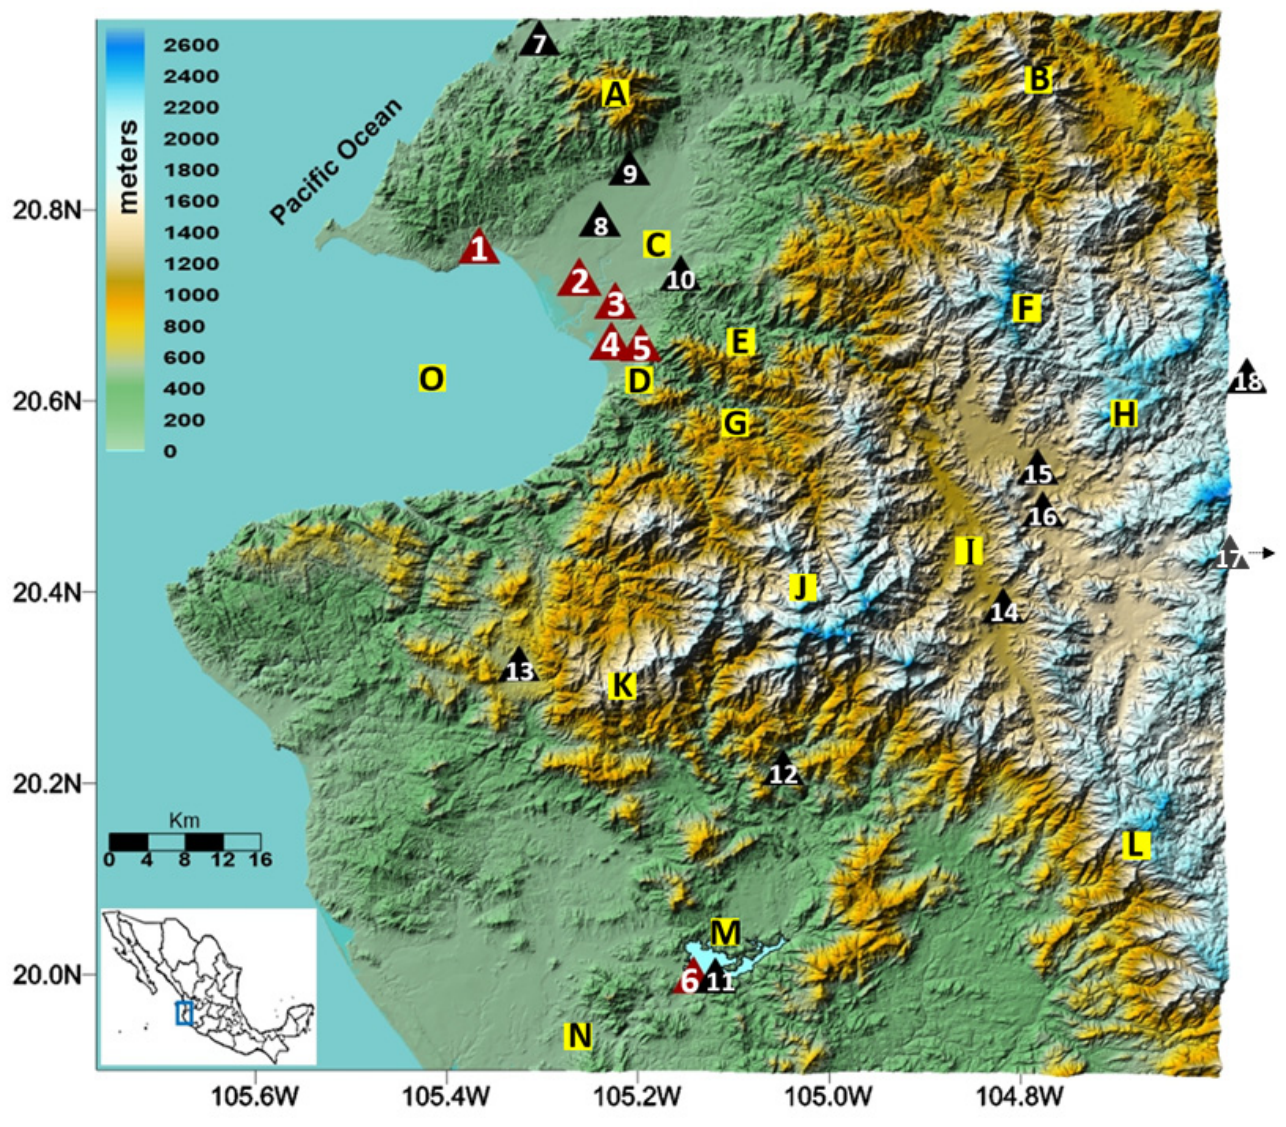
Figure 1. Digital elevation model in 3D [18]. Significant topographic features are indicated with black capital letters: (A) Vallejo Mountain; (B) La Cumbre Hill; (C) Ameca River Valley; (D) Puerto Vallarta City; (E) Pitillal River; (F) La Bufa Hill; (G) Cuale River; (H) Jolapa Mountains; (I) Talpa de Allende City; (J) El Cuale Mountain; (K) El Tuito Mountain; (L) Cacoma Mountain; (M) Cajón Peña Dam; (N) Tomatlán City; (O) Banderas Bay. The stations used for 24-h validation are indicated with red triangles: (1) Tec Ny; (2) Asfalto; (3) CUC; (4) Prepa PV; (5) Coapinole; (6) Tomatlán River; and the black triangles indicated the stations used for the spatial validation: (7) Monteón; (8) Valle de Banderas; (9) San Juan; (10) La Desembocada; (11) Cajón Peña; (12) El Bramador; (13) El Tuito; (14) Talpa; (15) Mascota; (16) Corrinchis; (17) Mixtlán; (18) San Gregorio.